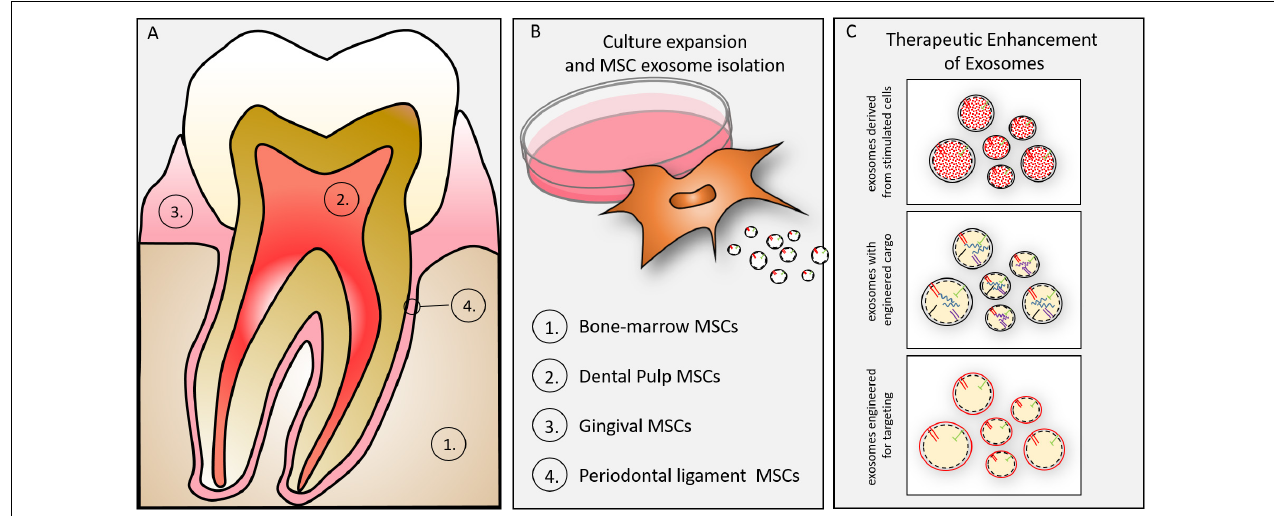
FIGURE 3 | (A) Oral tissue-specific cell types are sources of unique exosomes. Exosomes have been isolated from cells of (1) bone, (2) dentin/pulp, (3) gingiva, and (4) periodontal ligament. These cell-type specific exosomes may provide lineage specific direction to craniofacial tissue engineering. (B) Culture expansion and MSC exosome isolation. MSCs can be isolated from many oral/craniofacial tissues and expanded in culture. MSCs have been isolated from bone marrow, dental pulp, gingiva and periodontal ligament. (C) MSC derived exosomes can be enhanced for therapeutic advantage by several techniques including (1) parental cell stimulation (e.g., growth factor, culture conditions), (2) engineering to direct inclusion of overexpressed miRNAs, (3) engineering to include membrane proteins (e.g., integrins) to target exosomes to tissues (or cells).